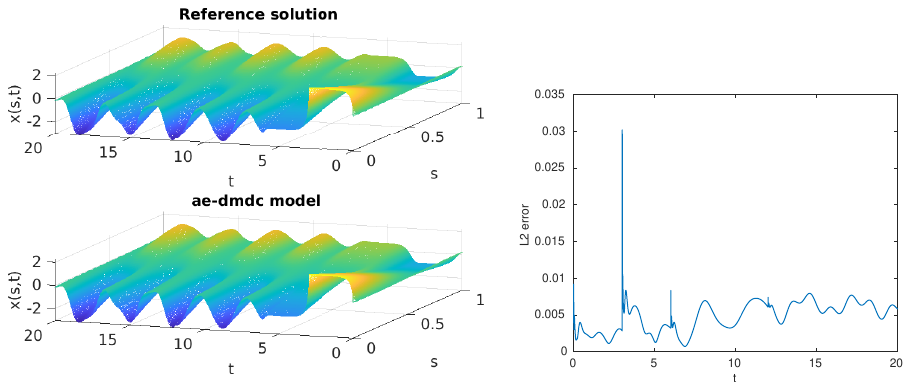
Figure 5. ( Left ): Comparison of the original solution (top) and the approximated one obtained with the low order ae-dmdc model obtained by combining the trained autoencoder with the DMDc approximation (bottom). ( Right ): Approximation error